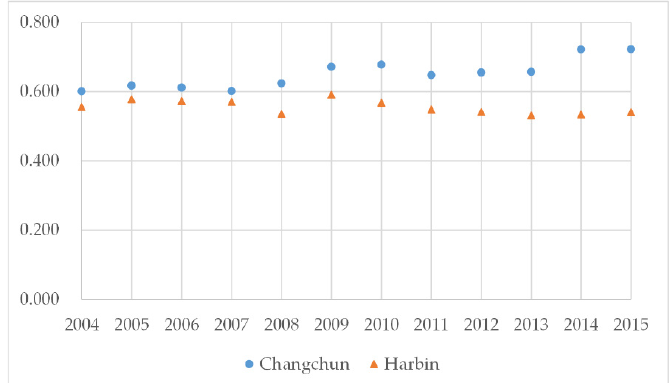
Figure 7. Characteristics of the LCCC in the core cities of the HCUA during 2004–2015.